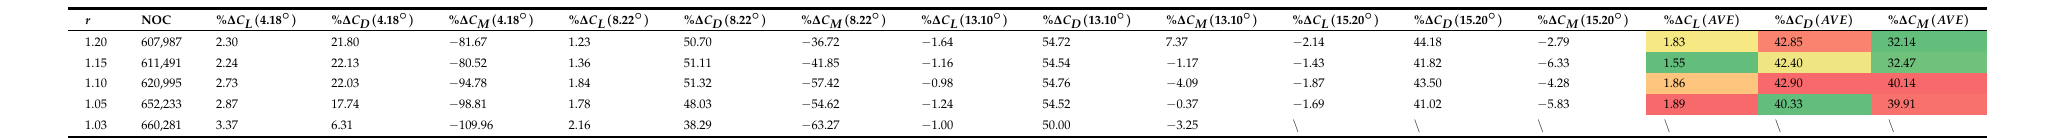
Table 16. Comparison of results of Hybrid-mesh based on various layer-wise growth rates with that of experimental benchmark data adopted from [25] in relative